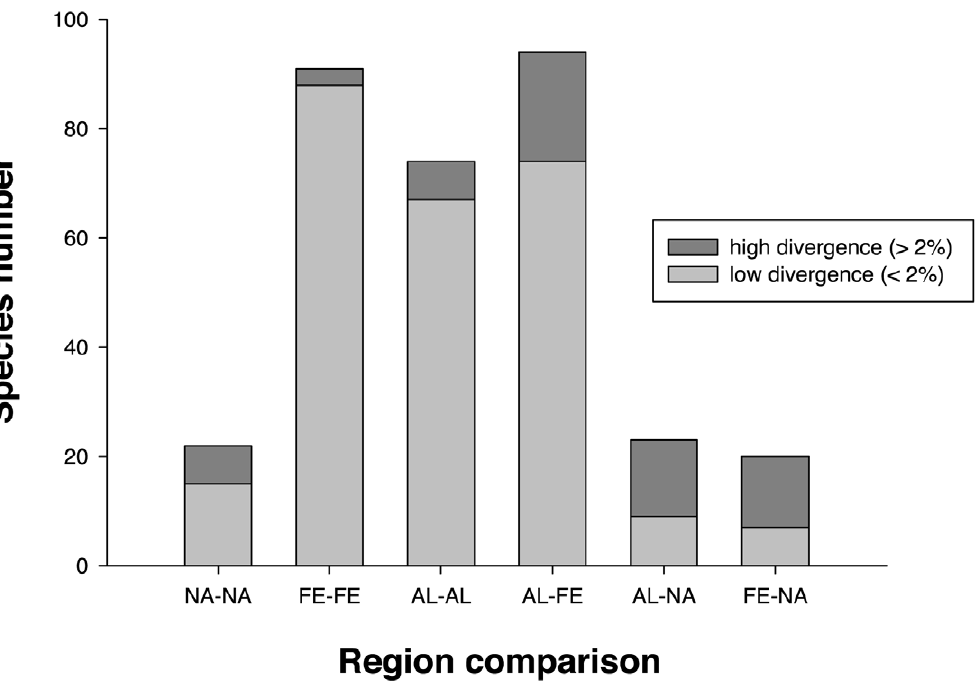
Figure 1. Proportion of high ( . 2%) intraspecific maximum divergences in DNA barcodes within and between regions. NA (North America), AL (Alps), FE (Fennoscandia).